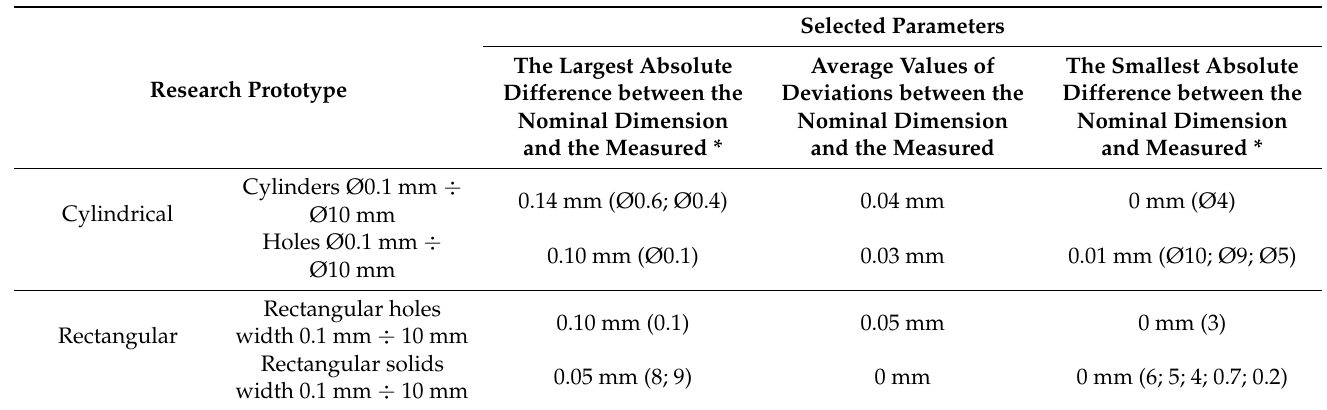
Table 7. Comparison of selected parameters of the research prototypes.